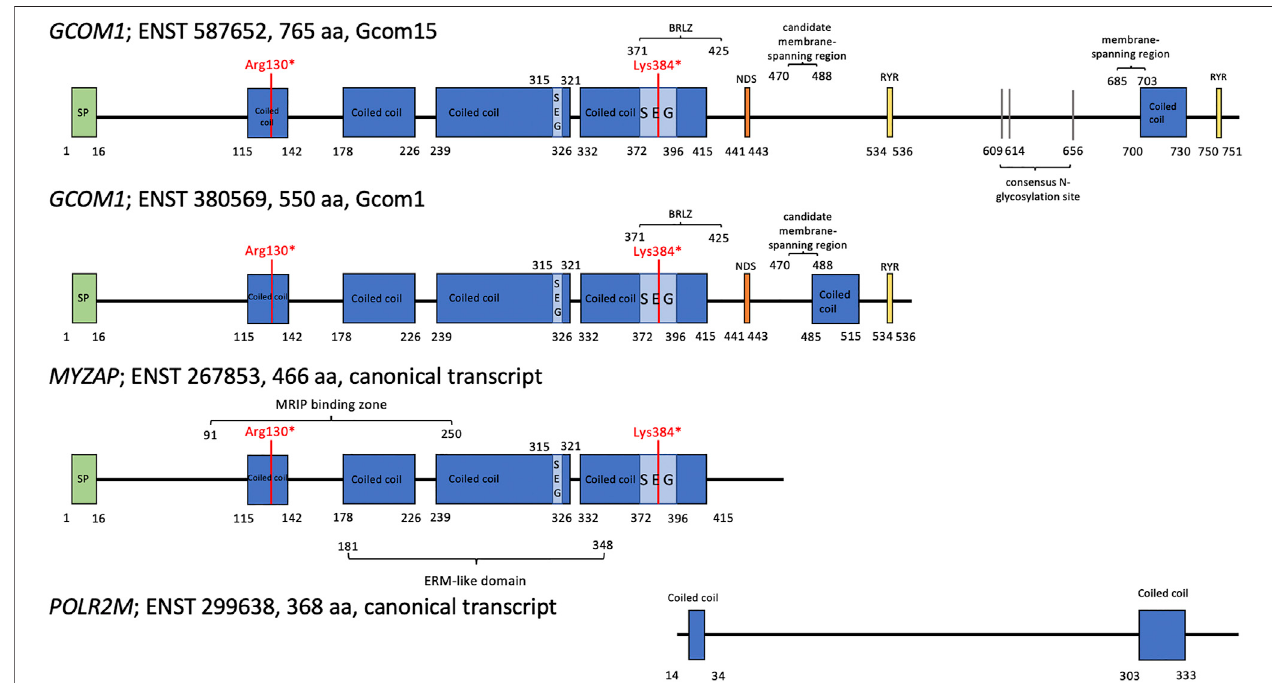
FIGURE 1 | Four GRINL1A transcripts. Abbreviations: aa for amino acid, SEG for low complexity region; NDS for asparagine-linked glycosylation site; BRLZ for BRLZleucinezipper;SPforsignalpeptide.Thetwo GCOM1 variantsaremarkedinred;Arg130*for GCOM1 c.388C > T,p.(Arg130*)andLys384*for GCOM1 c.1150 A > T, p.(Lys384*) (Roginski et al., 2004; Seeger et al., 2010; Roginski et al.,